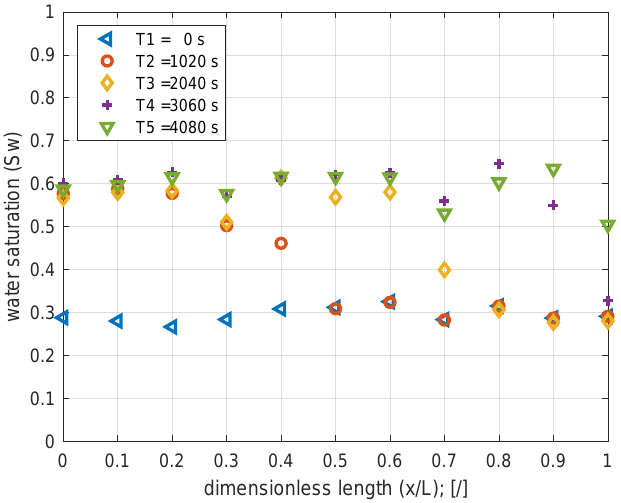
Figure 9. Experimental frontal advance displacement (M =